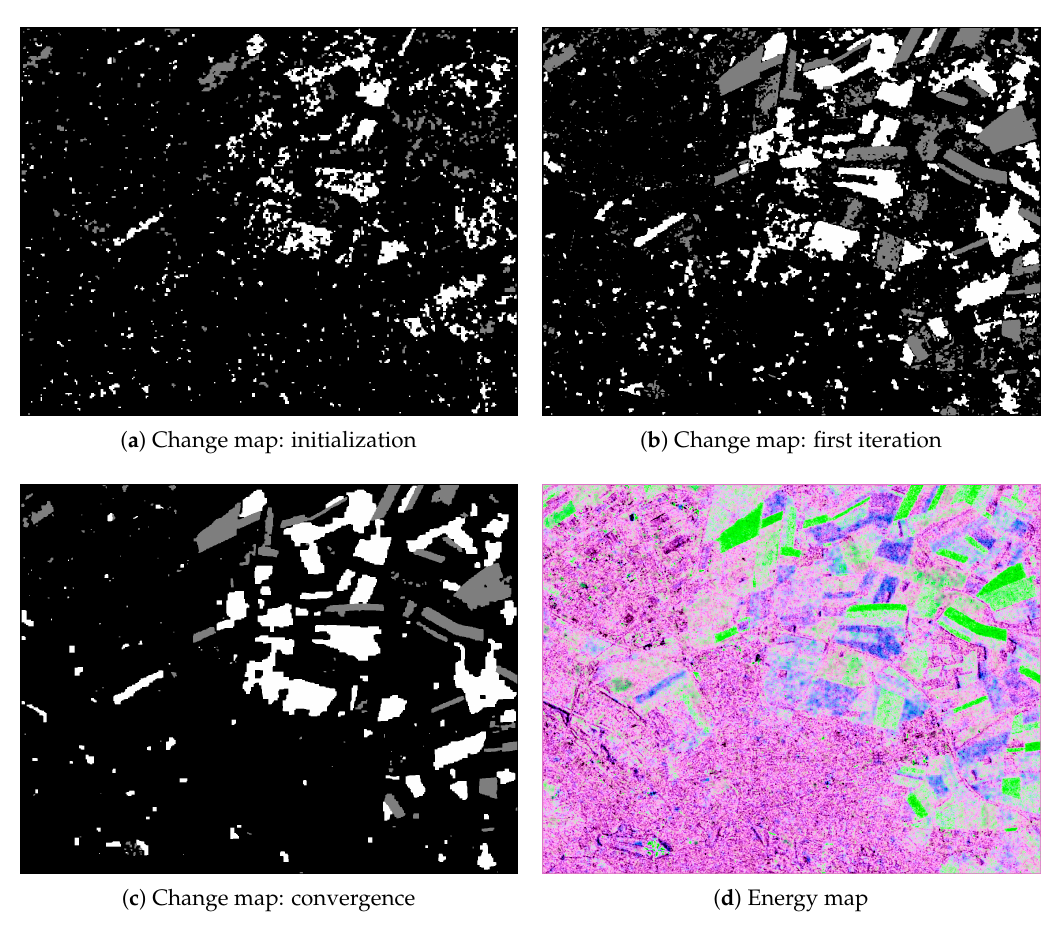
Figure 4. Outputs of the proposed method. Concerning the change maps, the color legend is: black = no-change; grey = change with increased backscattering; white = change with decreased backscattering. Concerning the energy map, the RGB composition of each pixel corresponds to the negative of the energy contribution associated with that pixel and conditioned to one of the three classes: R = no change; G = change with increased backscattering; B = change with decreased